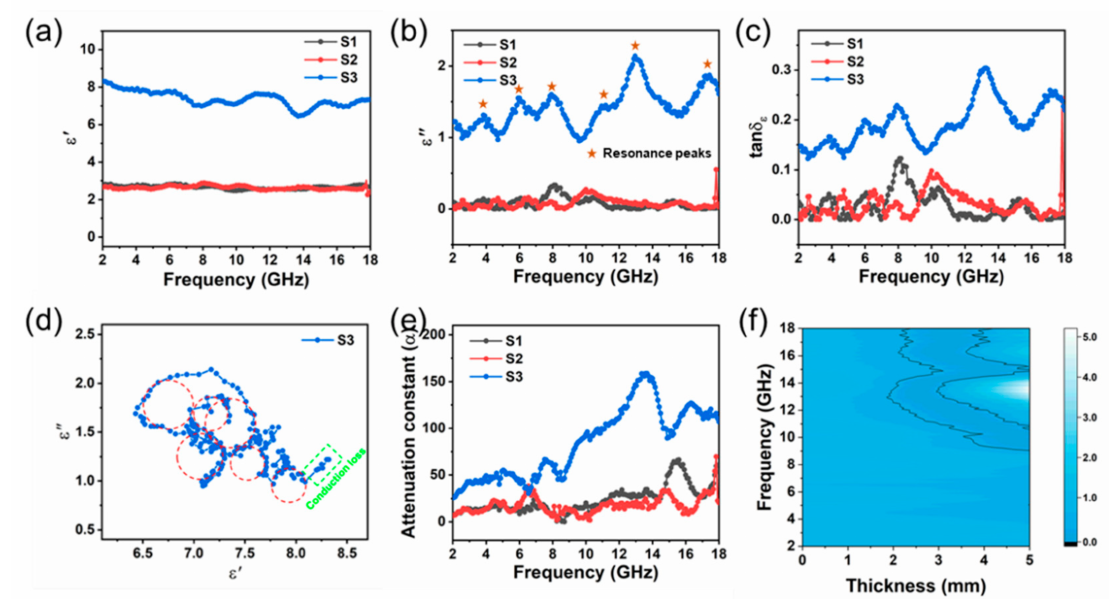
Figure 8. Frequency dependence of ( a ) ε (cid:48) ( b ) ε (cid:48)(cid:48) and ( c ) dielectric loss tangents of S1–S3; ( d ) Cole–Cole semicircles of S3; ( e ) the attenuation constant of S1–S3; ( f ) the calculated delta value maps of S3. (Black line, | ∆ | =